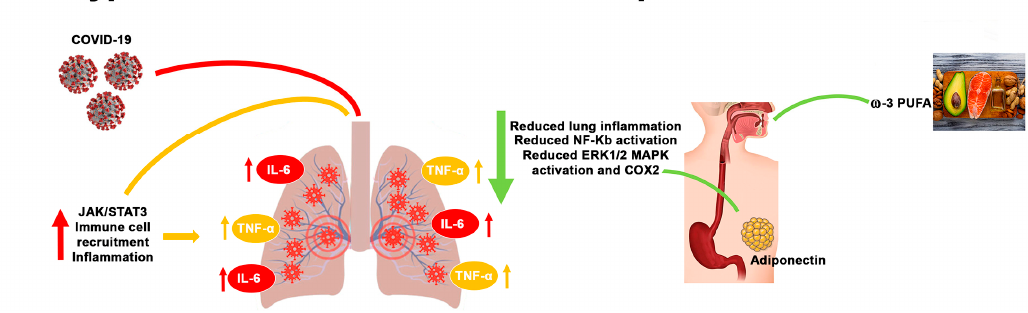
Figure 2. Adiponectin and ω -3 PUFAs reduce the lung inflammation that occurs following coronavirus infection, reducing IL-6 production, ERK1/2, and COX-2 activation and the nuclear infection, reducing IL-6 production, ERK1 / 2, and COX-2 activation and the nuclear translocation of translocation of NF- κ B. NF- κ